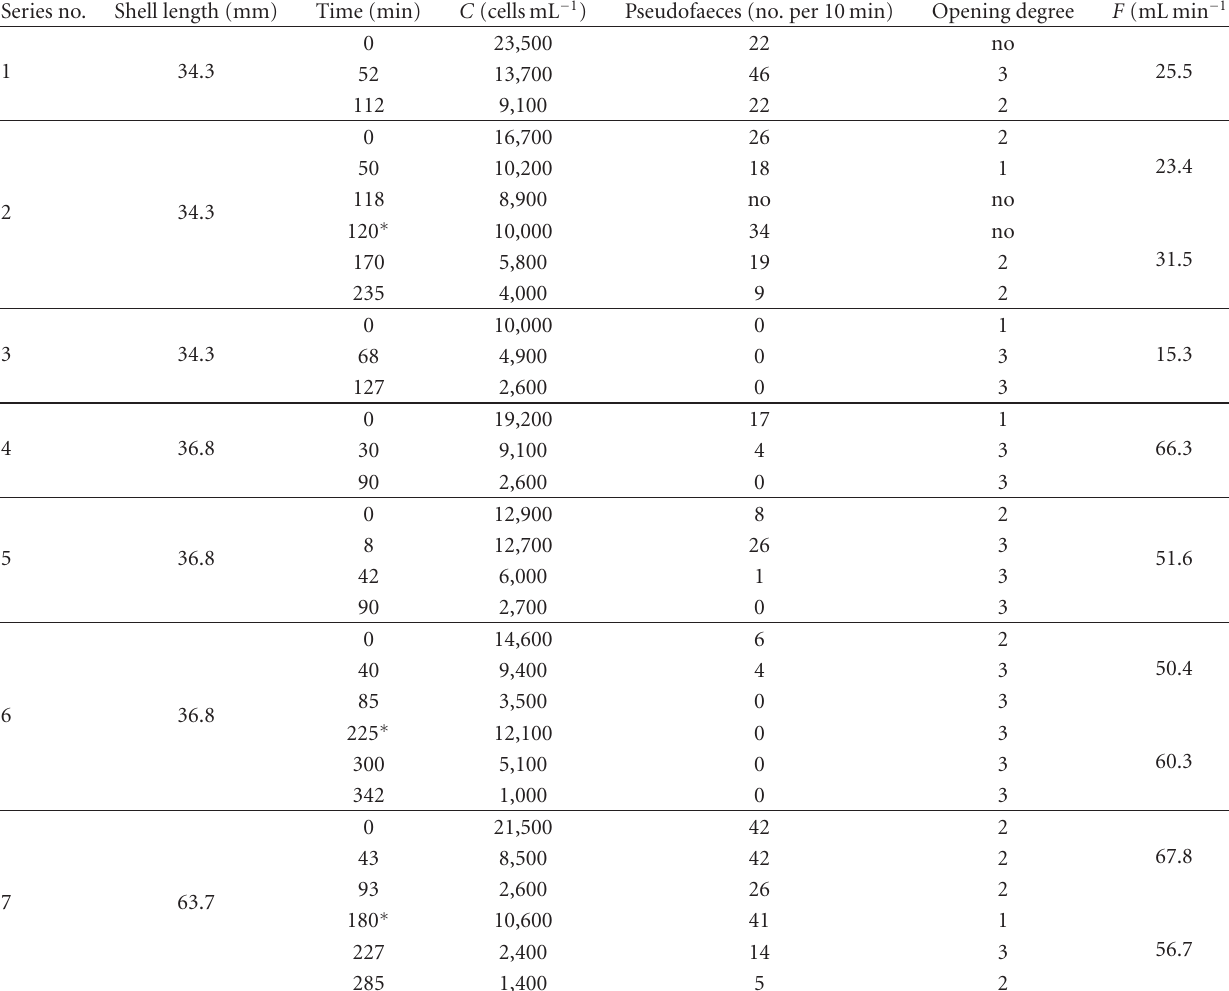
Table 3: Mytilus edulis . Pseudofaeces production by mussels exposed to di ff erent initial algal ( Rhodomonas salina ) concentrations. Opening degree symbols: 3: fully open, 2: reduced, 1: nearly closed. No observation = no. Filtration rate ( F ) using (2). ∗ New addition of algae. Series